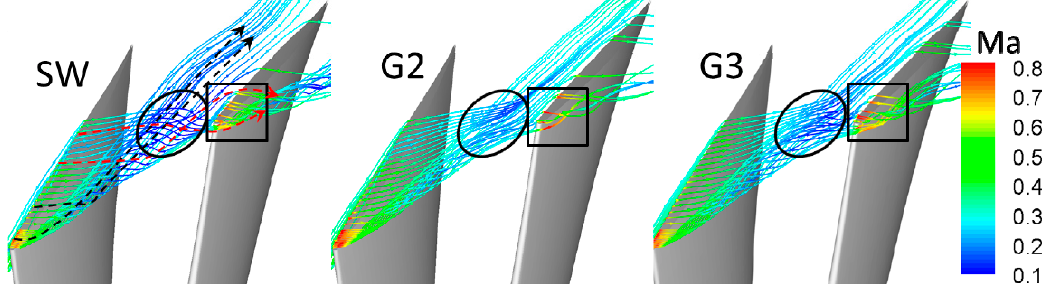
Figure 14. Time-averaged 3D flow streamlines released from mid-gap colored with relative Mach number.